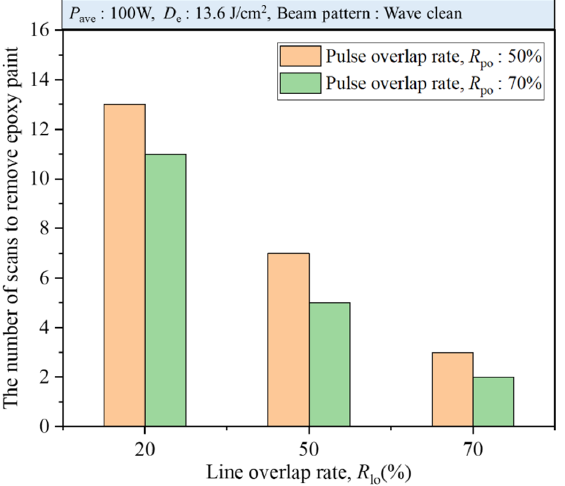
Figure 8. The number of scans to remove epoxy paint according to the laser beam overlap rates.